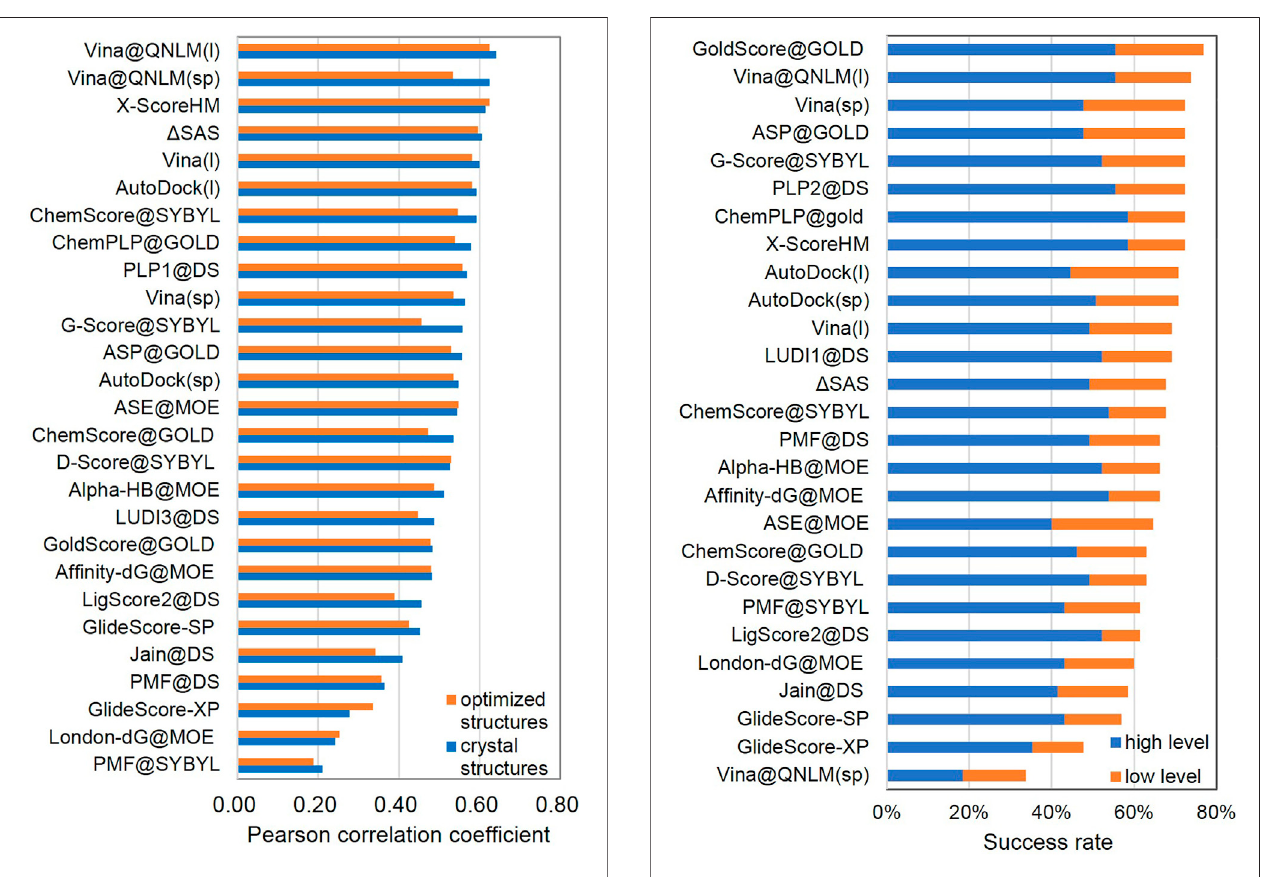
FIGURE 3 | Ranking power of high- and low-level success rate ofVina@ QNLM in single-point (sp) and local (l) modes (blue and orange bars), compared to the methods evaluated in CASF-2013 and